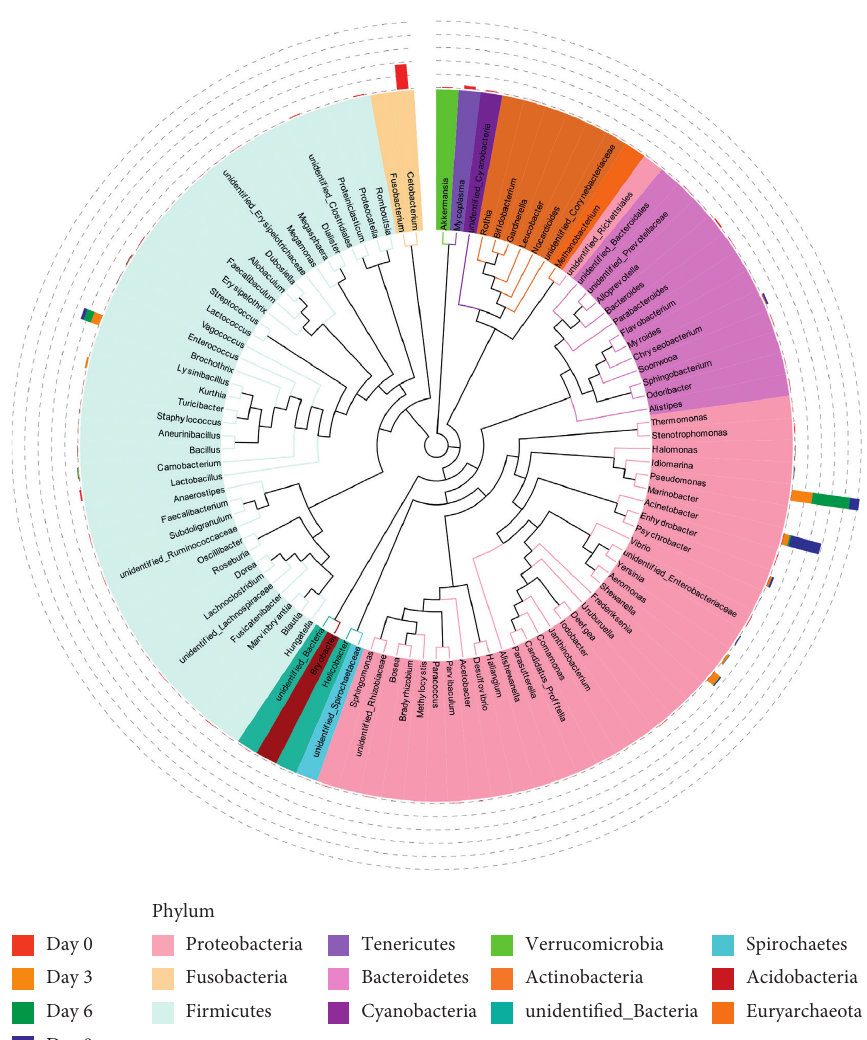
Figure 4: Phylogenetic tree based on 16S rDNA sequences on the genus level. Each color of the circle represents a phylum. The branches stand for different genera and the length of the branches indicates the evolutionary distance. The histogram shows the relative reads abundance of different